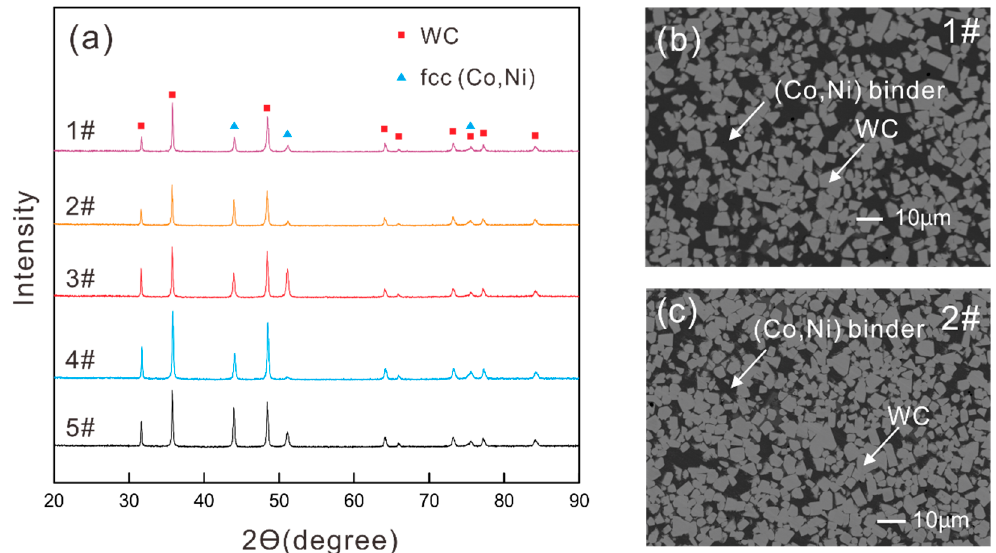
Figure 4. ( a ) XRD patterns of prepared WC-Co-Ni samples; SEM observations for ( b ) sample 1#; ( c ) sample 2#. Table 1. Measured thermal conductivity for each prepared two-phase WC-Co-Ni sample, in com- parison with the model-evaluated ones.